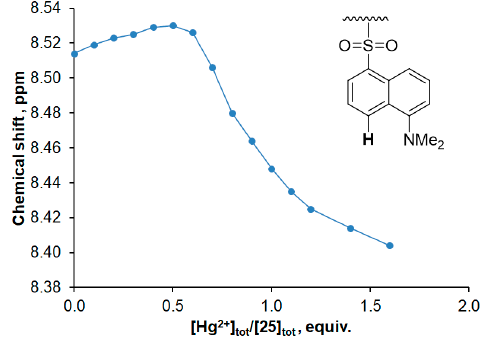
Figure 8. NMR titration of compound 25 with Hg(ClO 4 ) 2* 6H 2 O; changes in the chemical shift of the H4(Np) proton. C L 0.046 M, C Hg(II) 0.2 M.